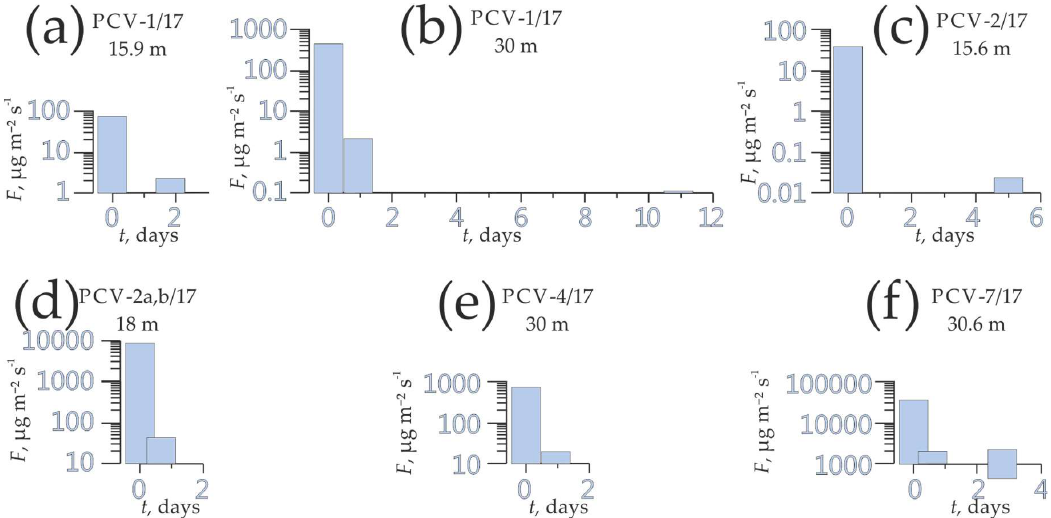
Figure 5. Changes in rates ν b /t of methane discharged from boreholes during chamber measurements: ( a ) PCV-1/17 (15.3 m), ( b ) PCV-2/17 (30 m), ( c ) PCV-2/17 (15.6 m), ( d ) PCV-2a,b/17 (18 m), ( e ) PCV-4/17 (30 m), and ( f ) PCV-7/17 (30.6 m). Table 2. Emission E of methane from boreholes as measured in closed chambers, time of chamber exposition t , maximum F 0 , and mean F gas release rates and equivalent diameter of degassing of permafrost around boreholes D . Estimates of average fluxes calculated with the relationship on Figure 6 are italicized. The diameters excessing the drilling diameter are marked in